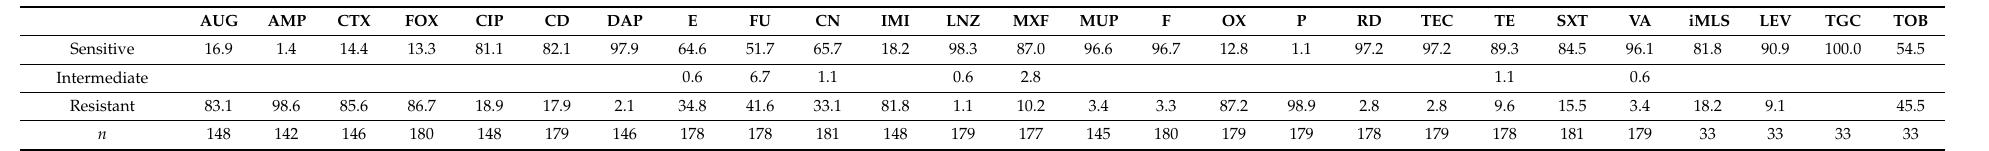
Table 1. Percentage sensitive, resistant, and intermediate methicillin-resistant Staphylococcus aureus isolates across 26 different antimicrobials in Ha’il, Saudi